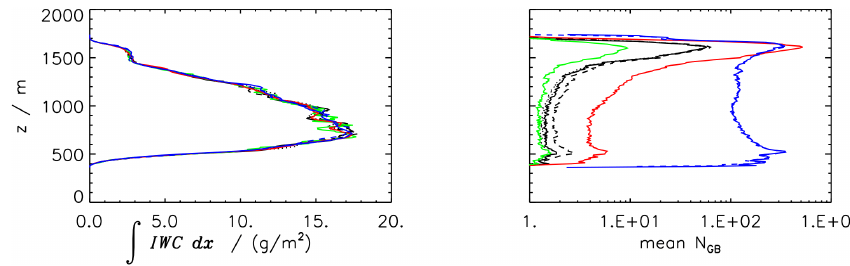
Fig. 4. Vertical profile of ice mass and mean N GB of a contrail-cirrus after 4h. Simulations and layout as in Figure 3